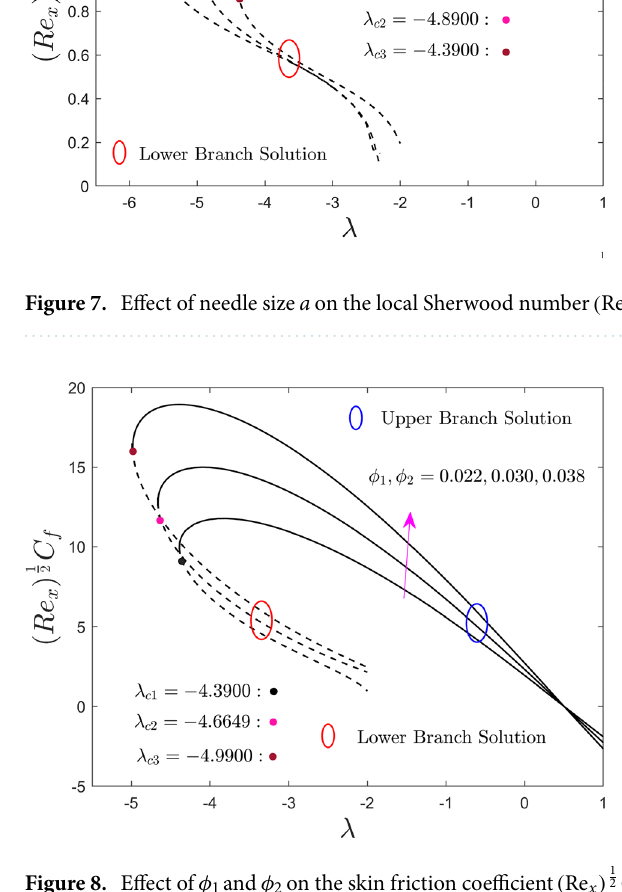
Figure 8. Effect of φ 1 and φ 2 on the skin friction coefficient ( Re x )